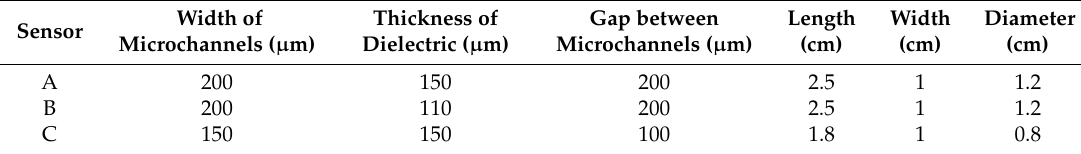
Table 1. Geometric dimensions of